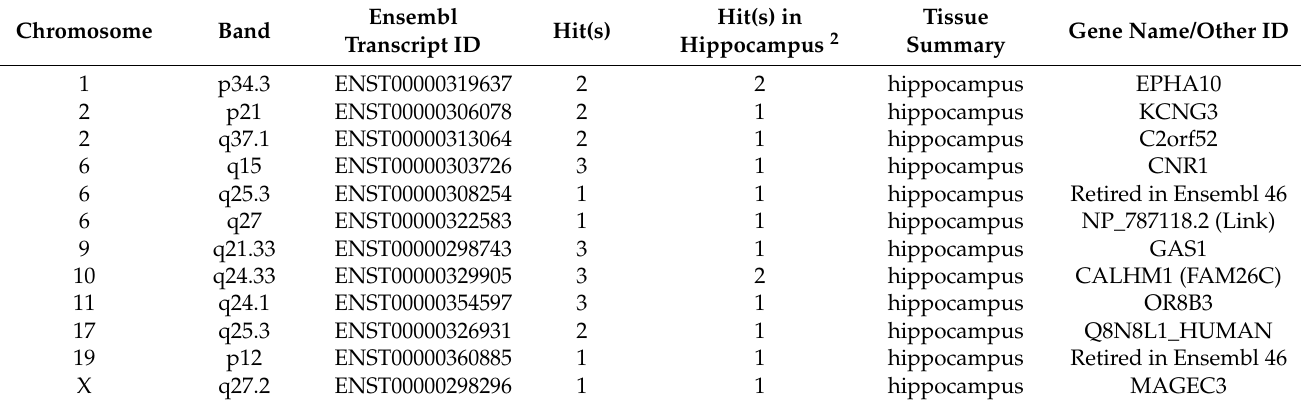
Table 7. Tissue Info expression screen 1